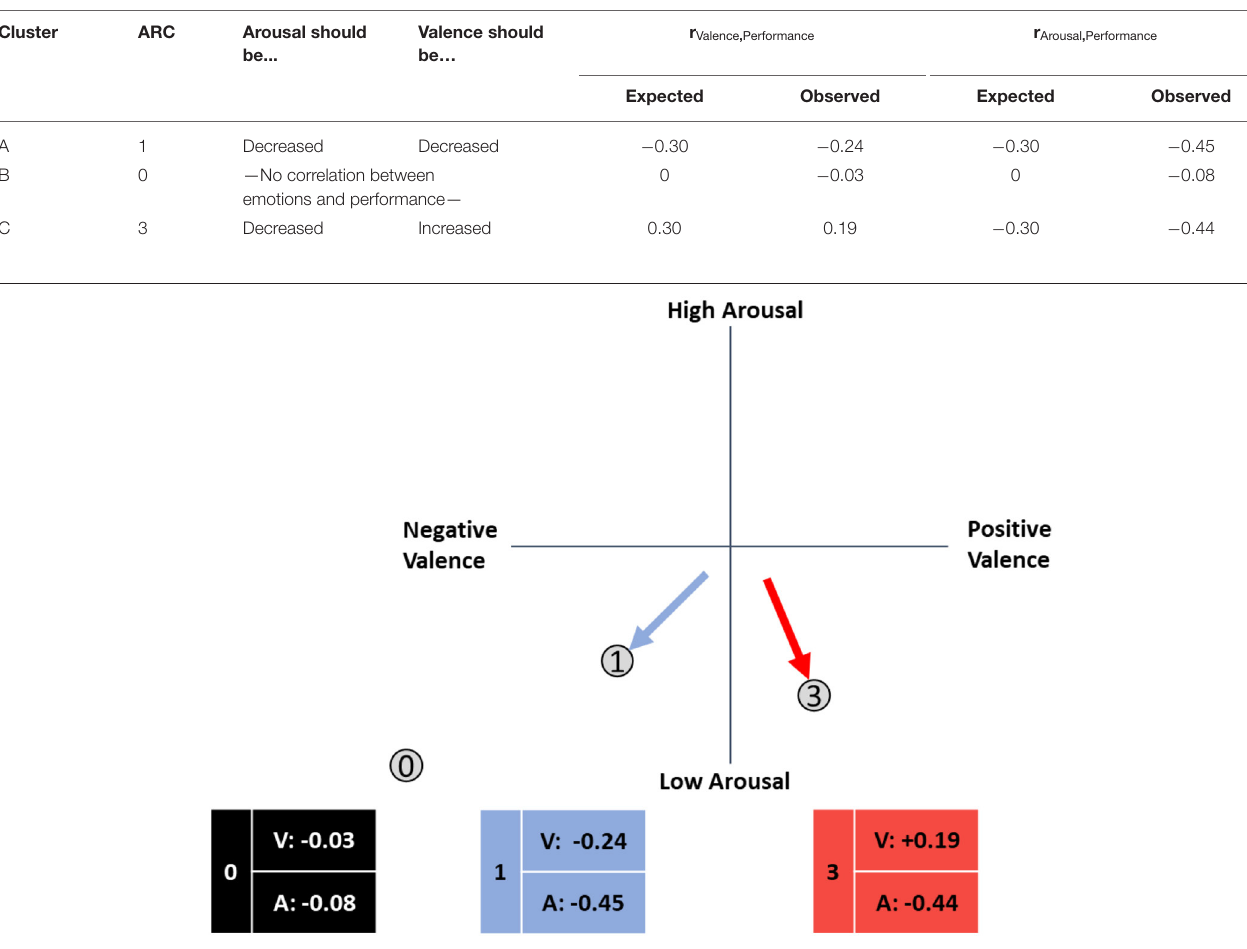
TABLE 3 | Assignment of clusters to hypothesized ARCs based on mean of the correlation coefficients within the clusters. Cluster ARC Arousal should Valence should r Valence , Performance r Arousal , Performance be... be… Observed